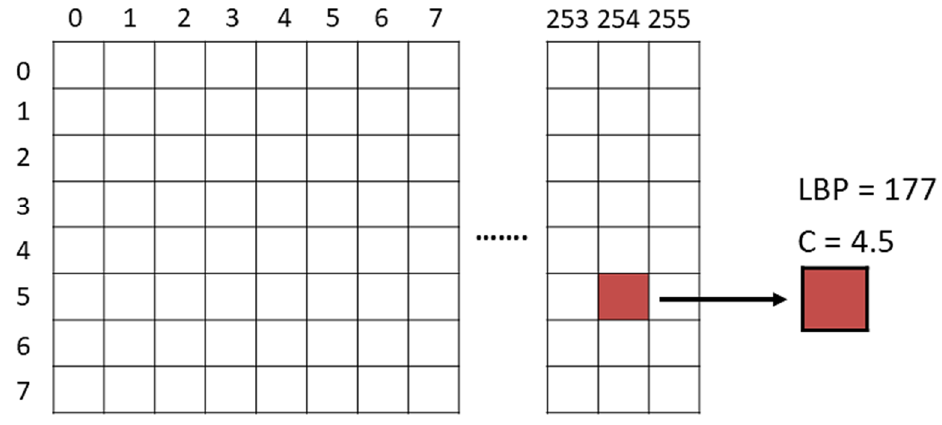
Figure 5. Bidimensional array of LBP/C.